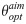
Behavioral data of Experiment 1.Reach angle (y-axis) over trials (x-axis): A) of a participant that experienced the steep reinforcement landscape, and B) of a participant that experienced the shallow reinforcement landscape, and C) averaged across participants that experienced either the steep (blue) or shallow (orange) reinforcement landscape, where shaded regions represent ± 1.0 SE. The grey vertical lines separate baseline trials (1-50), experimental trials (51-400) and washout trials (401-450). The dashed horizontal lines indicate the optimal intended reach aim (θoptaim) to maximize reward. In A) and B), during the experimental trials, the blue and orange circles respectively indicate that the participant received reward on a given trial, while the black circles indicate no reward. In C), the thick blue and orange curves represents the best-fit exponential functions to the reach angles of participants that experienced the steep or shallow reinforcement landscapes, respectively. The time constant (λ) of these exponential functions characterize the rate of learning and were found via a bootstrapping procedure. D) Posterior probability distributions of the exponential function time constants given the experimental reach angles (left y-axis) of participants that experienced the steep (λsteep, blue) or shallow (λshallow, orange) reinforcement landscapes. The thick lines are the corresponding cumulative distributions (right y-axis). The inset represents the posterior probability distribution of the time constant differences between the shallow and steep participants (i.e., λshallow − λsteep). As observed in C) and D), we found that participants who experienced a steep reinforcement landscape had a significantly faster rate of learning (i.e., λsteep < λshallow) than those that experienced a shallow landscape (p = 0.012).